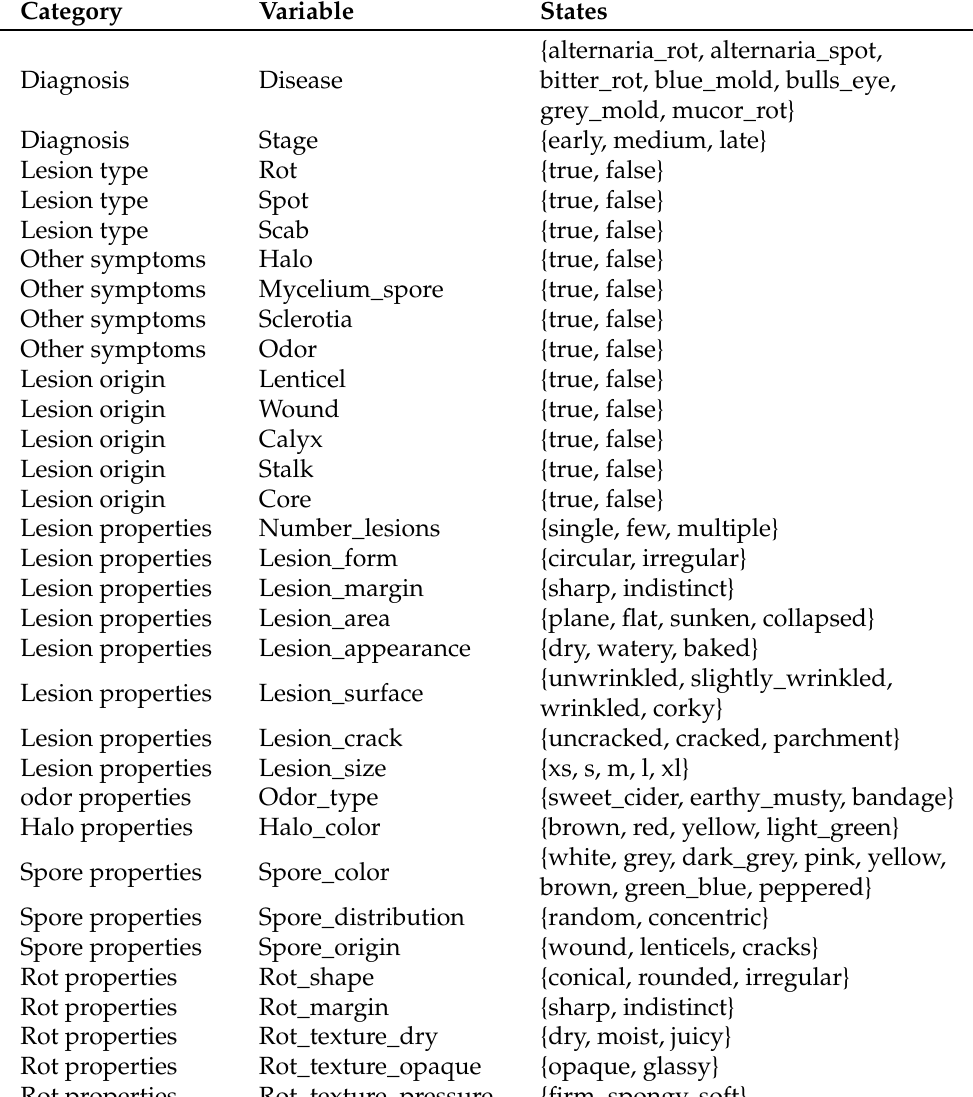
Table A1. Random variables and states included in the BN-DSSApple model, grouped by